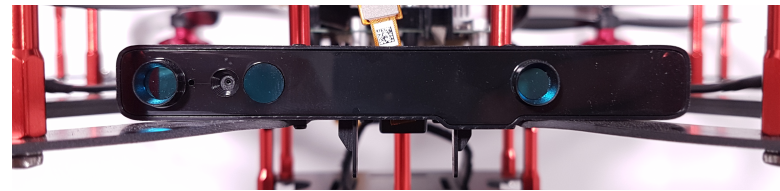
Figure 9. Intel RealSense R200 Camera mounted onto the Quanser